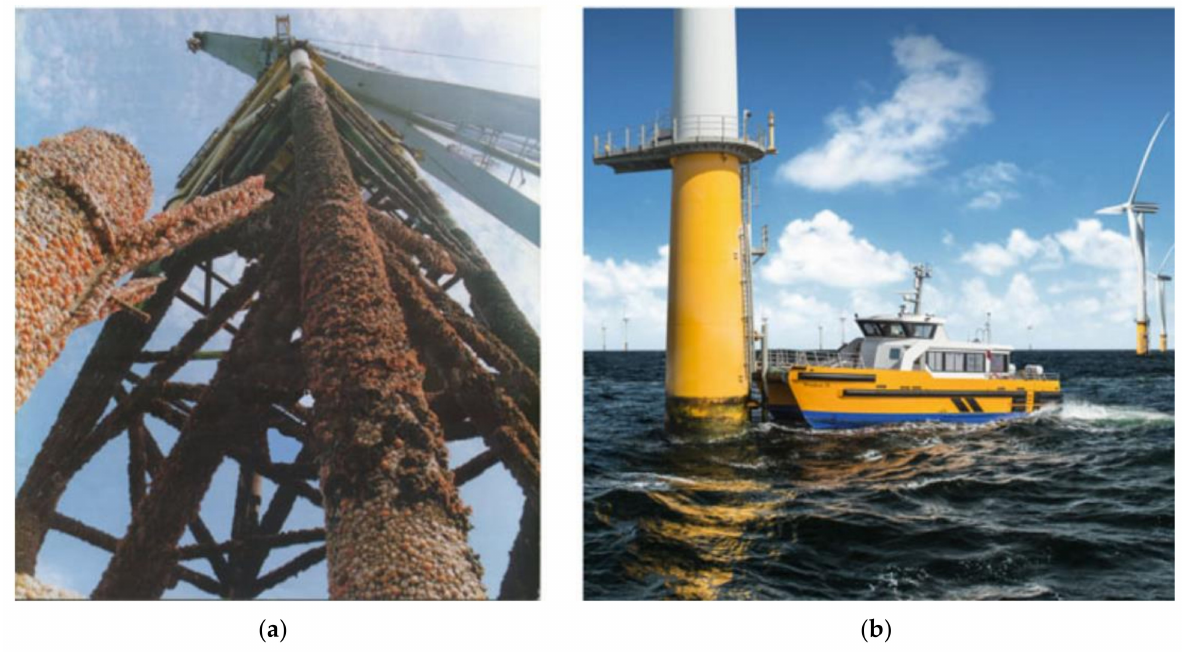
Figure 1. The accumulation of ( a ) biofouling on the ladder and ( b ) access to the turbines for mainte- nance (Source Windcat Workboats